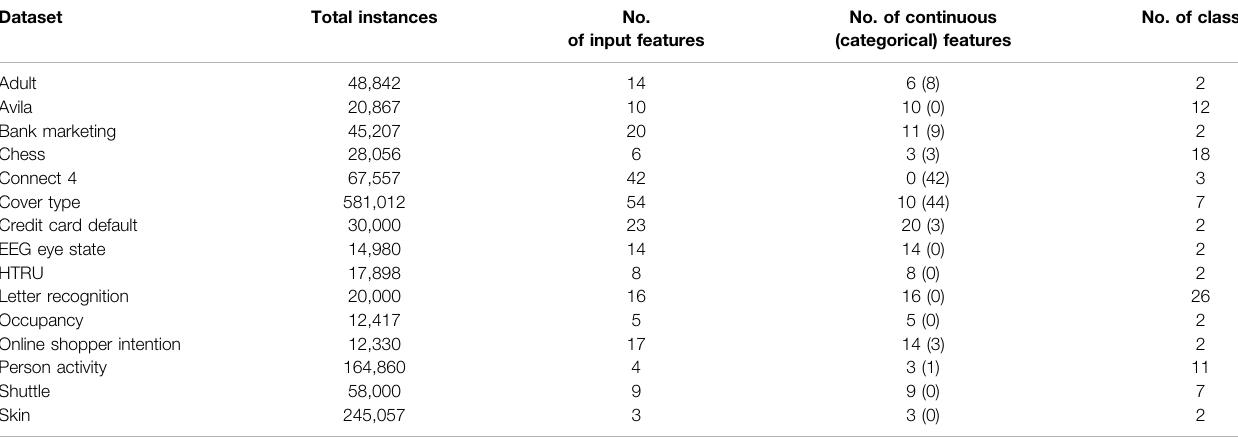
TABLE 1 | Properties of the selected